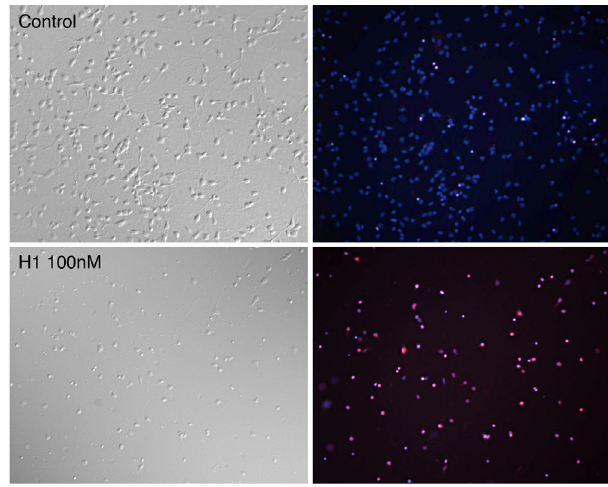
Figure 6. Effects of histones presented in the substratum on neuronal survival. Dissociated neurons were plated on substrate formed by binding histone H1, histone H3, and poly-D lysine to culture dishes at 1.25, 2.5, 5 and 10 μg/ml. Growth on immobilized histone H1 and poly-D-lysine was significantly increased at 5 and 10 μg/ml (one way ANOVA with Bonferroni’s post hoc correction) but was independent of substratum levels of histone H3.